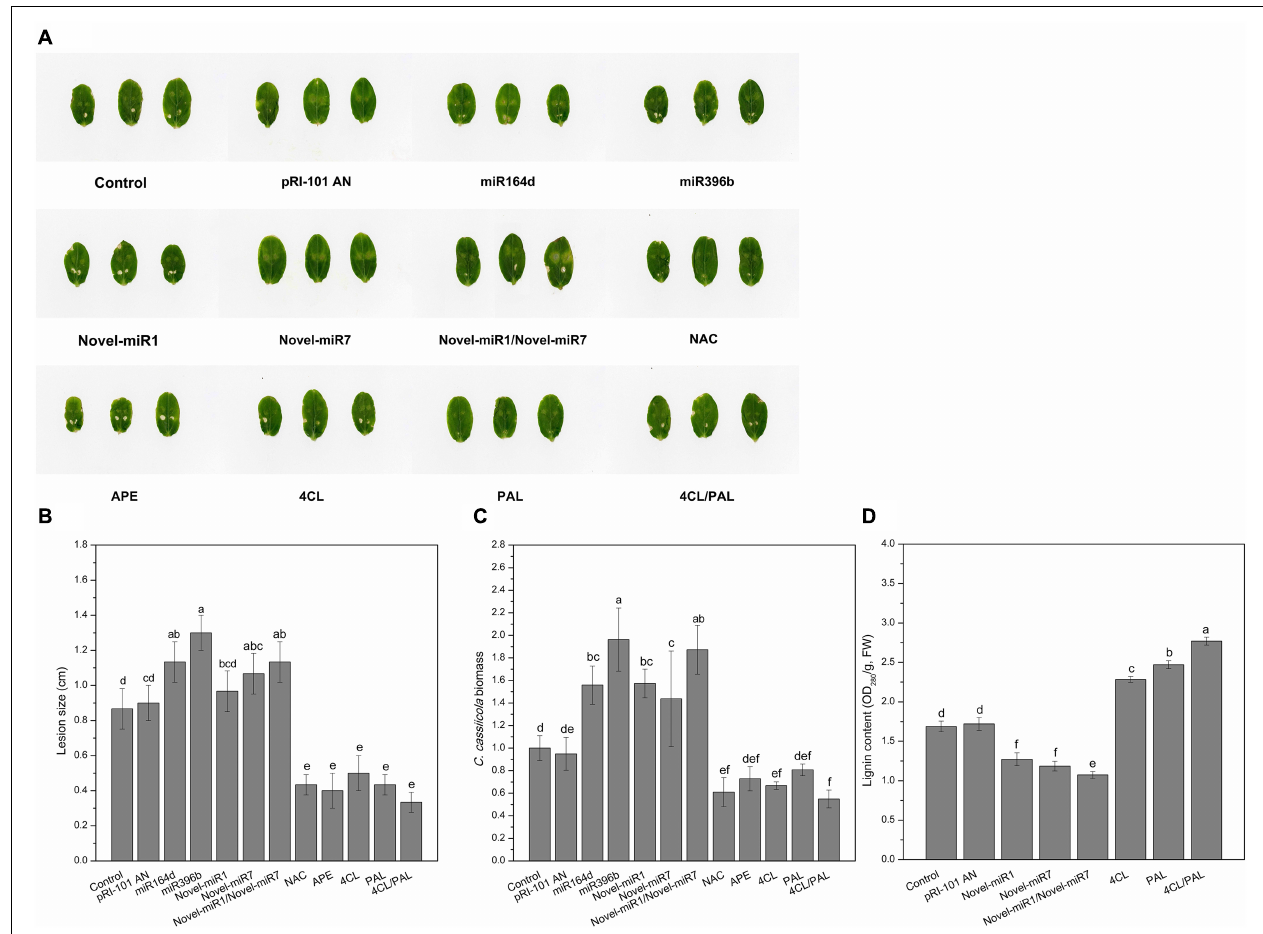
FIGURE 4 | Disease phenotype in cucumber cotyledons transiently expressing miRNAs and target genes after inoculation with C. cassiicola . (A) Disease symptoms of cucumber cotyledons. (B) Disease lesion size of cucumber cotyledons. (C) Biomass of C. cassiicola of cucumber cotyledons. (D) Effect of transient expression of miRNAs and targets on lignin content in cucumber cotyledons. Significance was determined by Duncan’s multiple range test ( P <